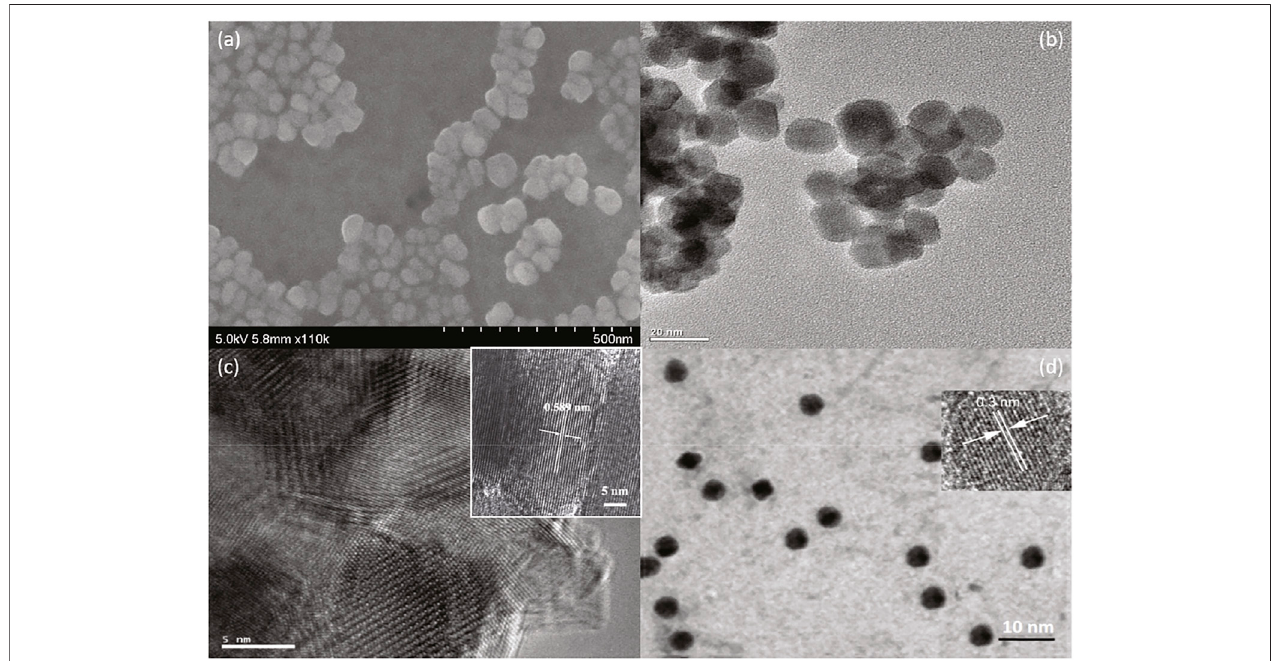
FIGURE 2 | SEM (A) , TEM (B) , and HRTEM (C) of NC2-4@SnS 2 ; TEM of NC2 CQDs (D) .